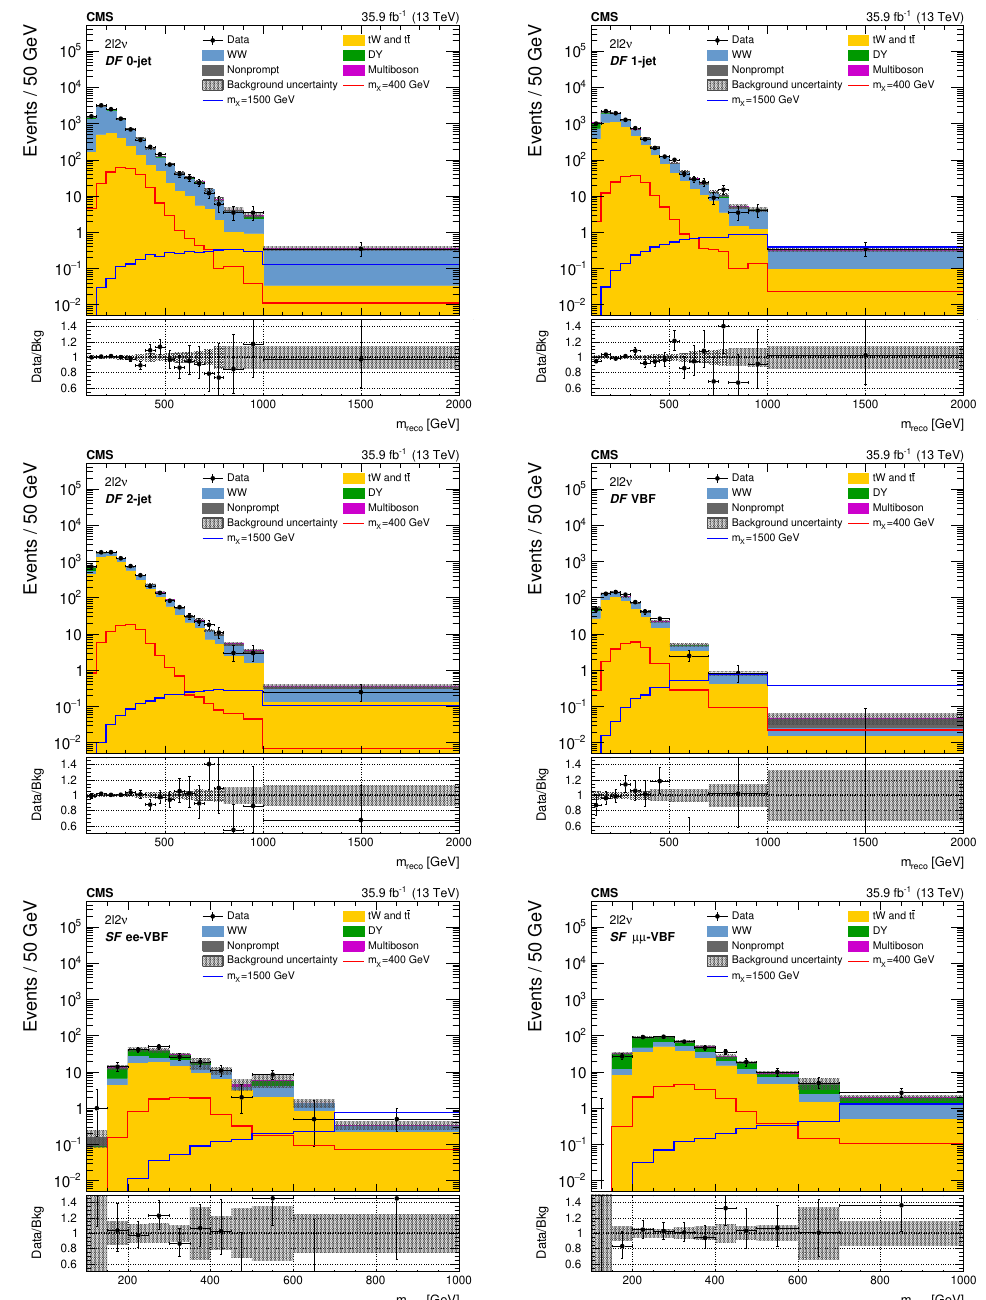
Figure 2 . The m distributions in the 2 ‘ 2 (cid:23) di(cid:11)erent- (upper and middle) and same-(cid:13)avour reco (lower) categories, after performing a background-only (cid:12)t with the dominant background normal- izations determined using control regions. The points represent the data and the stacked histograms the expected backgrounds. Also shown are the sum of the expected ggF- and VBF-produced sig- nals for m = 400 and 1500 GeV, normalized to the SM cross sections, and without considering X interference e(cid:11)ects. The hatched area shows the combined statistical and systematic uncertainties in the background estimation. Lower panels show the ratio of data to expected background. Larger bin widths are used at higher m ; the bin widths are indicated by the horizontal error bars. reco